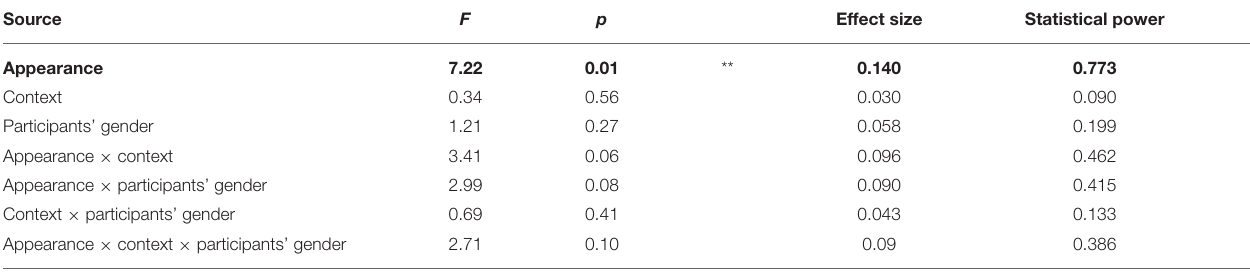
TABLE 4 | Results of three-way ANOVA for Q1 (trustworthiness).